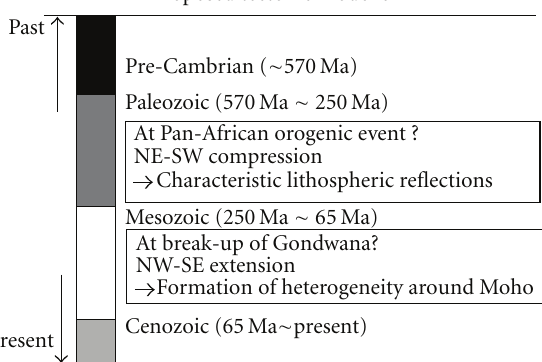
Figure 14: Summary of tectonic history proposed by seismological studies in LHB. Pan-African orogeny and Mid-Mesozoic break-up could be the major two events a ff ecting the formation of the present upper mantle